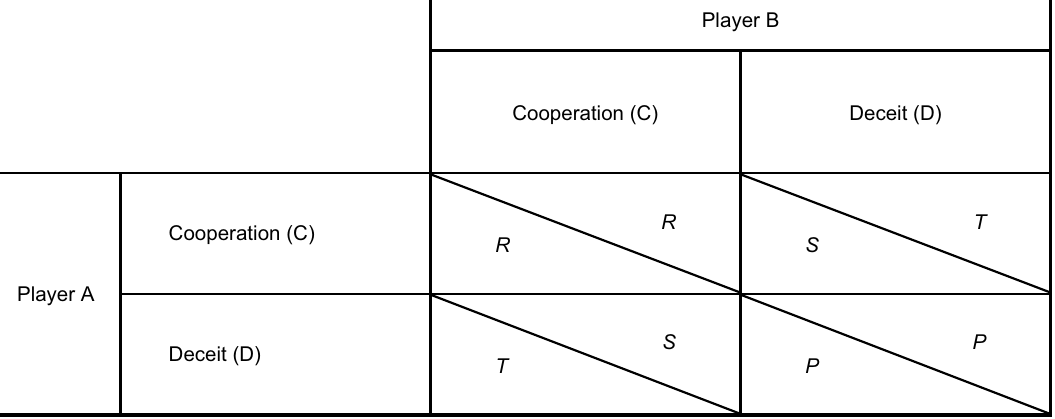
Figure 1. Pay-off matrix in the Prisoner’s Dilemma game, showing the consequences (gains or losses) in function of the decisions (cooperation (C) or deceit (D)) by both players. The symbols S , P , R , and T denote the benefits in each possible condition for Player A (below the diagonal) and Player B (above the diagonal). For the game to be a social dilemma, it is required that S < P < R < T and 2 R > S + T